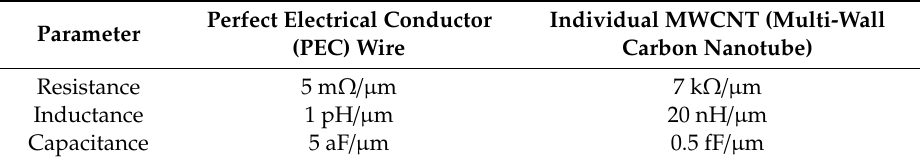
Table 1. Comparison of lineic electrical properties of a 10-nm-diameter